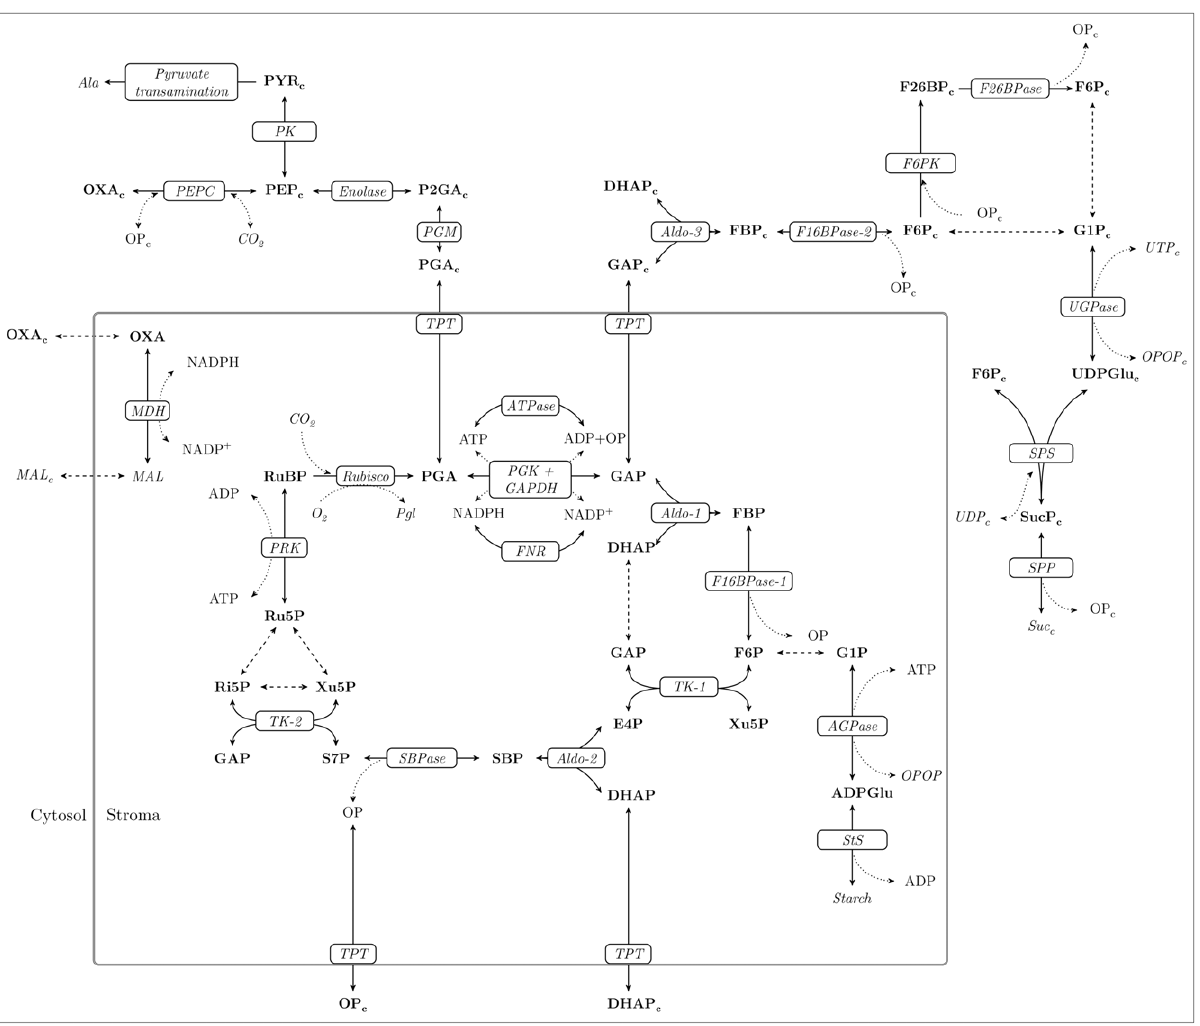
Figure 3. Network underlying the SK-model of the CBC and related pathways. Compounds written in italics represent external substances the concentrations of which are kept constant in the model. Dotted lines indicate the reactions of cofactors. Dashed lines connect metabolites that are assumed to be in equilibrium so that their concentration changes are directly proportional to each other. The proportions of the individual concentrations of these metabolites then depend solely on their equilibrium constants.